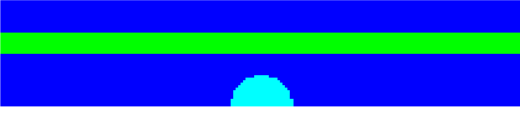
Figure 5. Numerical model.